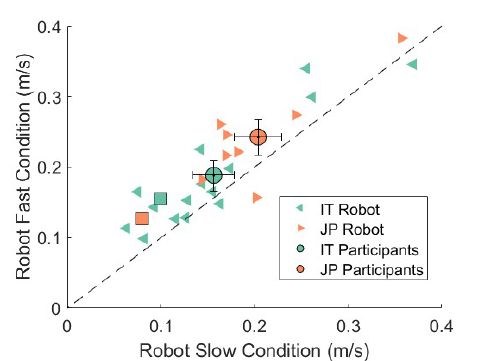
Figure 9: Mean subject’s speeds for each of the ten repetitions (“OneBox”), with shaded areas representing error bars. The dashed lines represent the speeds of the robot, equal across all ten repeti- tions (Japan).